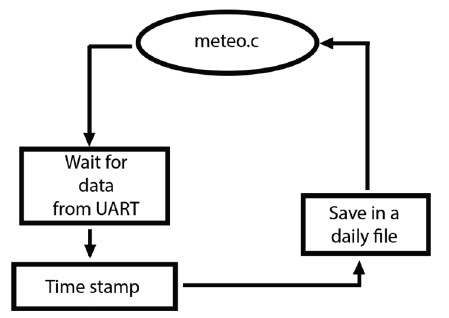
Figure 6. Flowchart of the meteo.c application